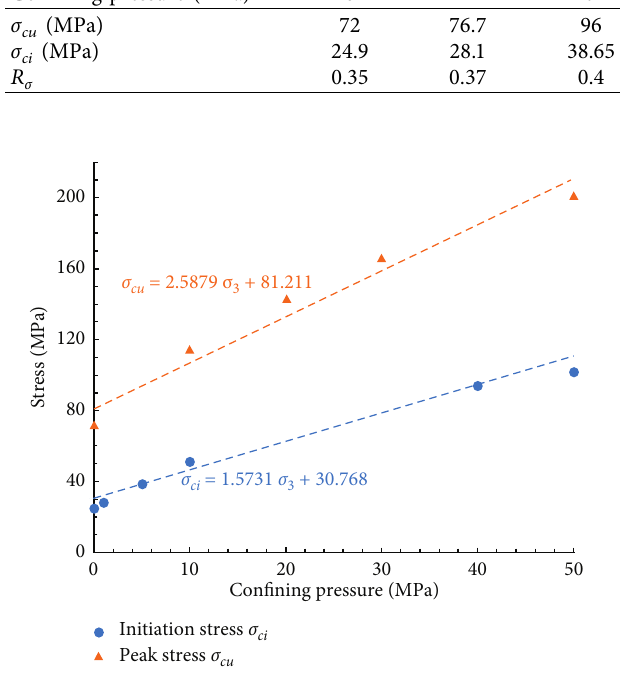
Figure 12: Variation in σ